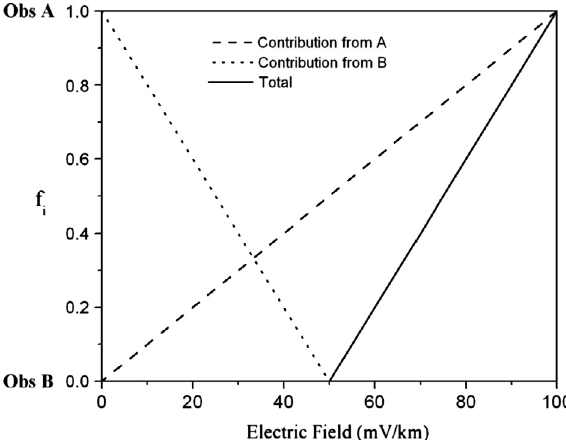
Fig. 9. Relative contributions when using linear interpolation between the electric fields calculated for Observatory A and Observatory